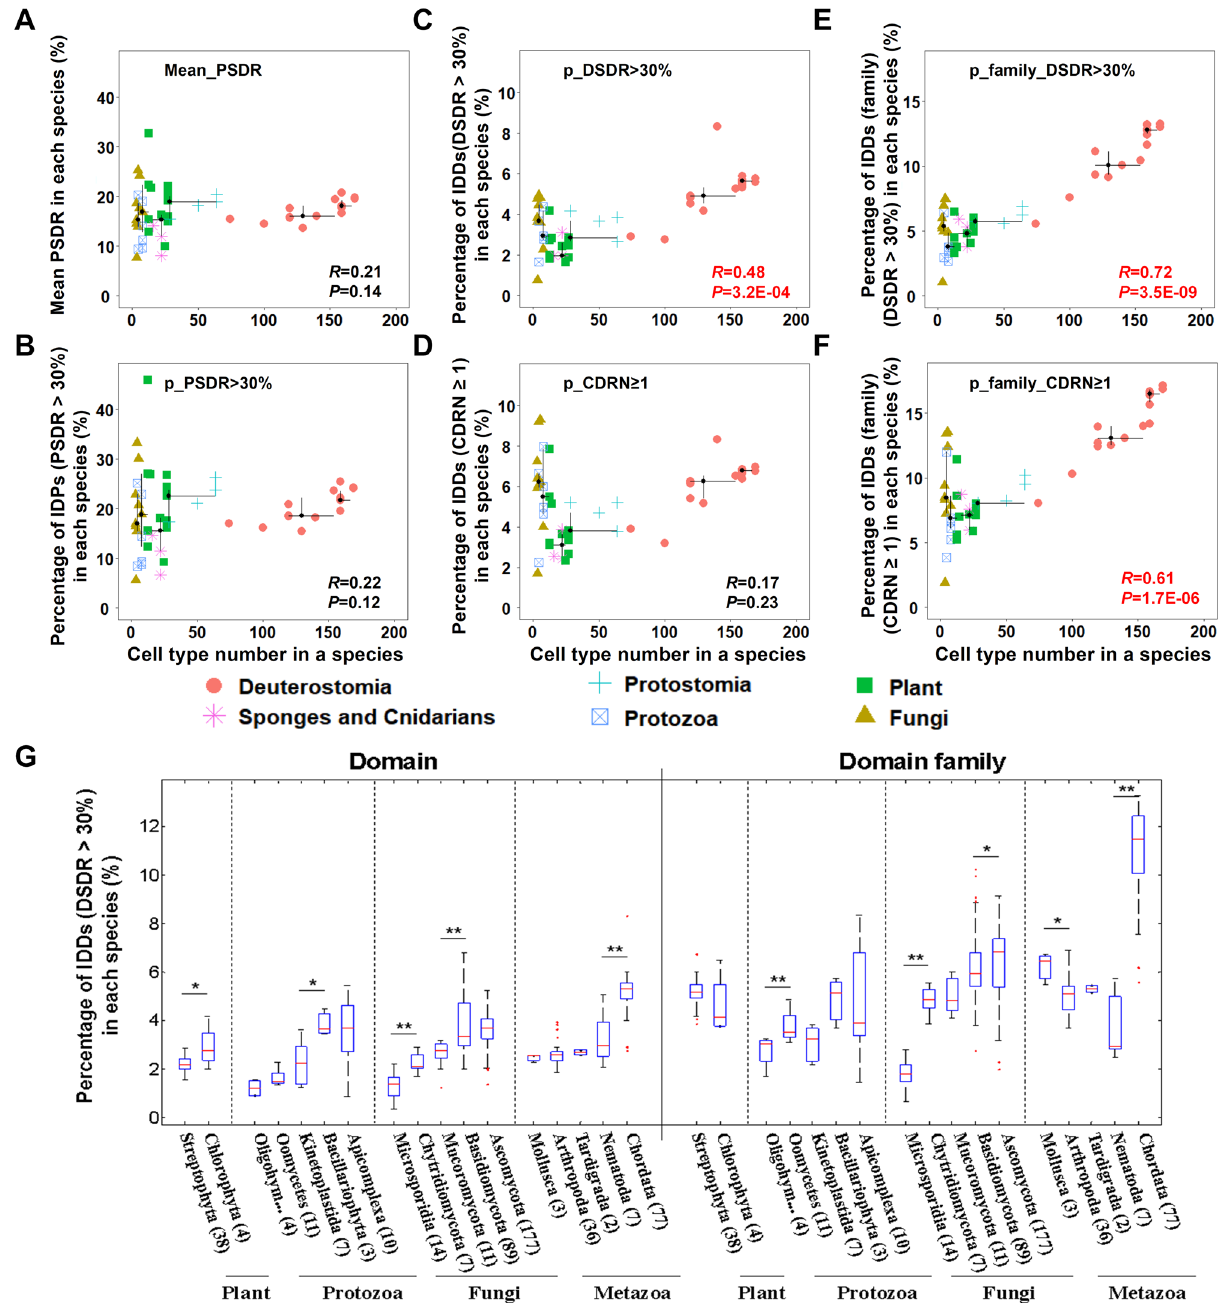
Figure 2. The correlation between structural disorder and organism complexity. ( A ) Protein disorder degree was measured by the average of all representative proteins (the longest one for each gene) in each species. ( B ) Proteins with more than 30% disordered amino acids (PSDR > 30%) were regarded as disordered proteins. Protein disorder degree was measured by the percentage of disordered proteins in each species. ( C, D ) At domain level, structural disorder of each species was measured by the percentage of IDDs (C, DSDR > 30%, or D, CDRN ≥ 1). ( E, F ) At domain family level, domain families were defined using dominant category method; structural disorder of each species was measured by the percentage of intrinsically disordered domain families ( E , family_DSDR > 30%, or F, family_CDRN ≥ 1). Scatter plots was made for organism complexity and structural disorder values obtained by different methods in fifty-one eukaryotes. Spearman method was used for the correlation analysis. The correlation coefficients (R) and P values ( P ) are shown in the inset, among which the significant results are shown as red. ( G ) Box-plot of the percentage of intrinsically disordered (DSDR > 30%) domains (left panel) or domain families (right panel) in each species across the different phyla of eukaryotes. The four kingdoms of eukaryotes are marked on the bottom of the figure. The values of upper and lower quartile, and the median values are indicated as bars in the boxes. The differences in percentage of disordered domain distribution between adjacent categories are examined by Mann–Whitney U test. The corrected P values are marked as stars in sub-figure G (* P < 0.05; ** P <